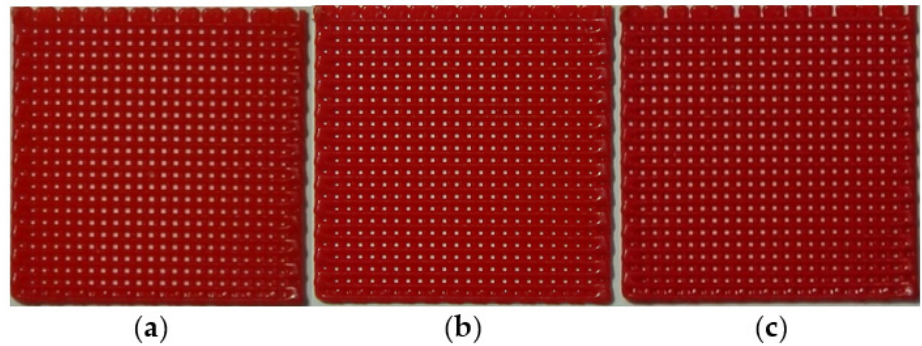
Figure 3. Fabricated lattice-patterned membranes with different pigment concentrations: ( a ) 5, ( b ) 10, and ( c ) 15 wt.%.